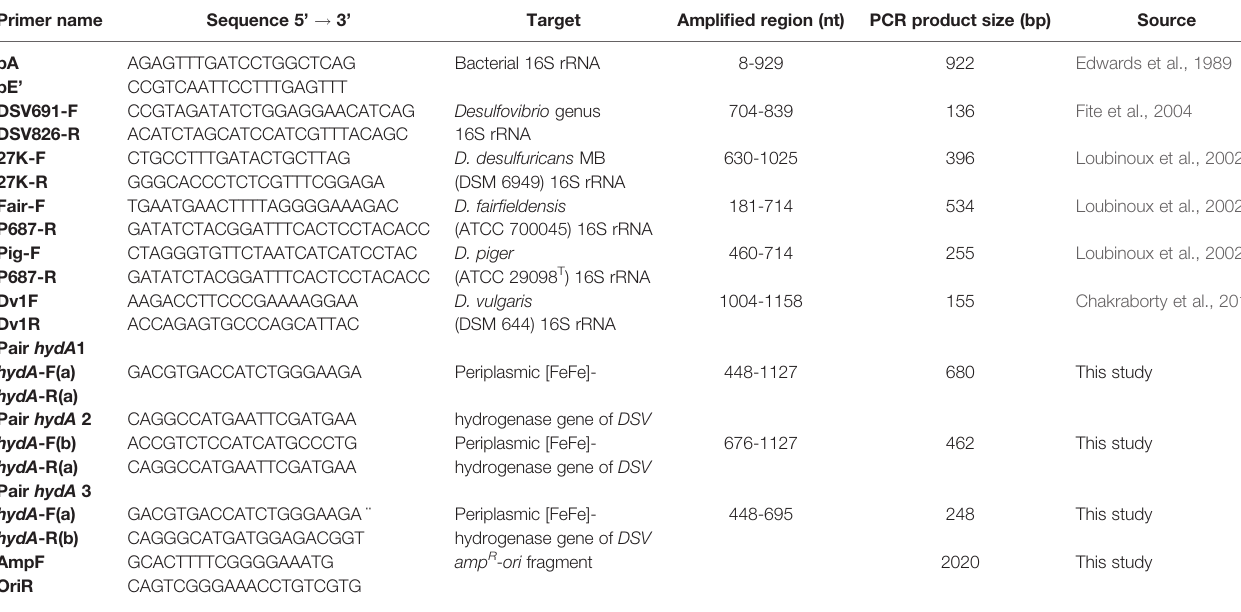
TABLE 1 | Primers used in the